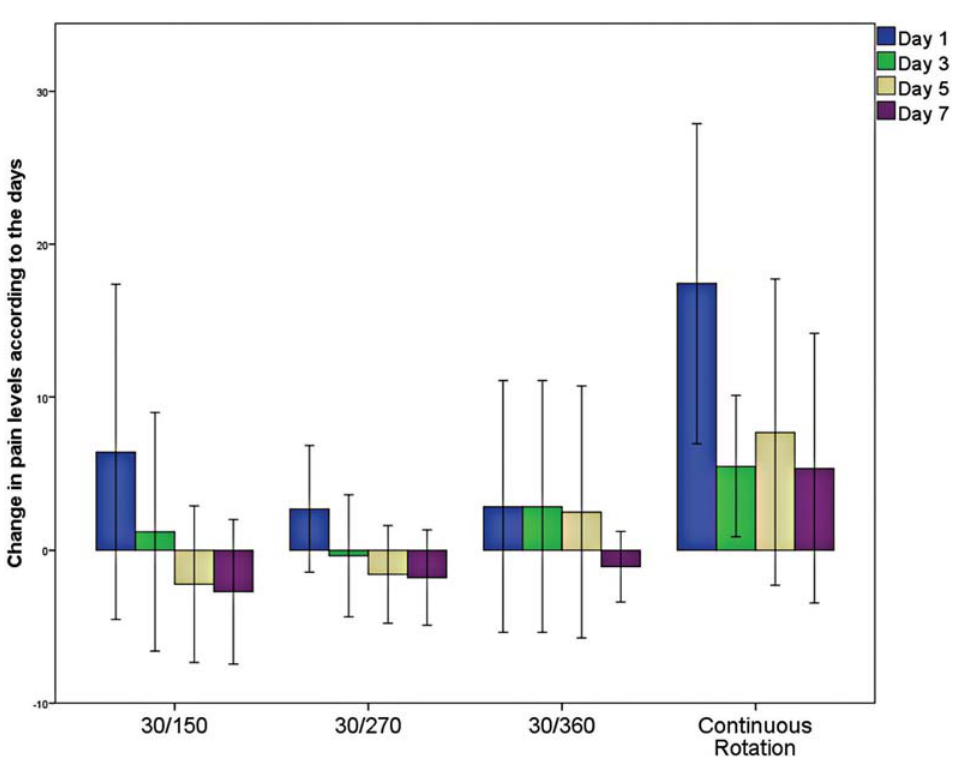
Figure 2- Change in pain levels according to the days. Change in pain was calculated at the day based on the preoperative pain. Continuous rotation increased pain at Day 1 in comparison with other reciprocating groups (360° CCW - 30° CW and 270° CCW - 30°